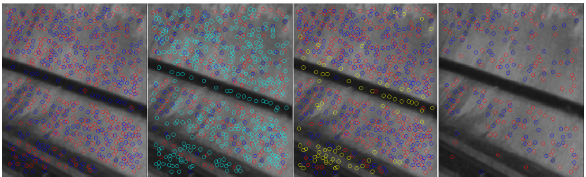
Figure 8. Detection of interest points: From the left: Local maxima points (minimum/maximum), Low-contrast points (cyan), risk of repetitive points (yellow), final points.